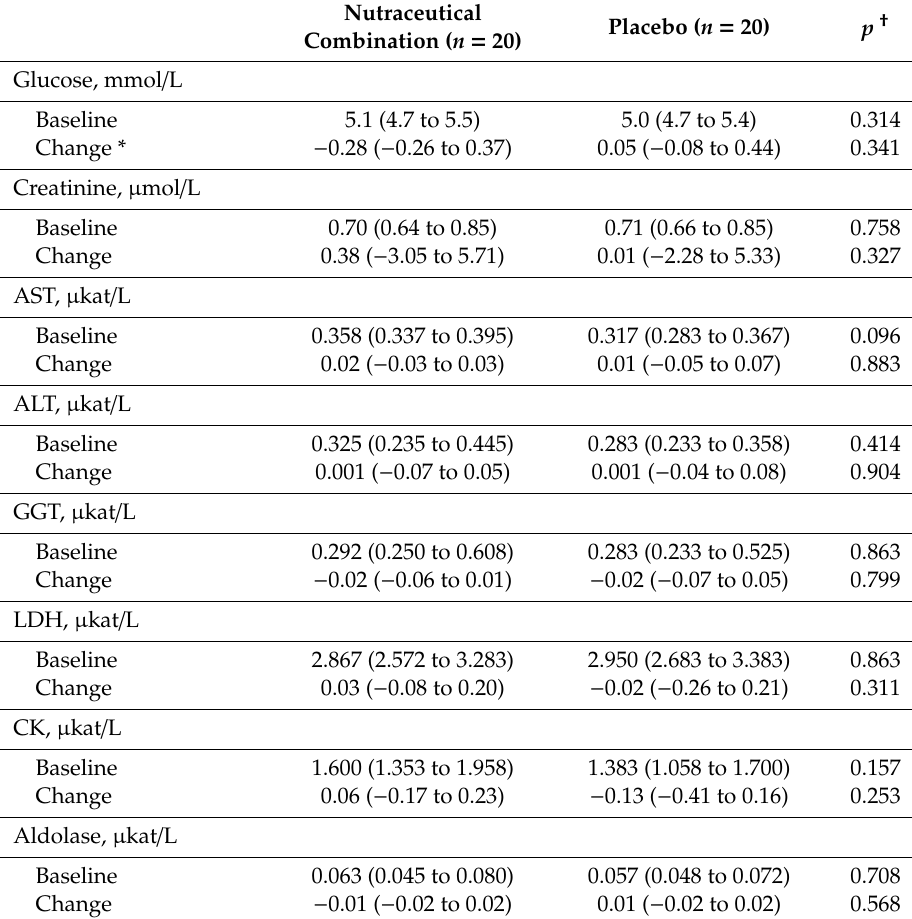
Table 2. Baseline and three-month changes in safety laboratory variables by group